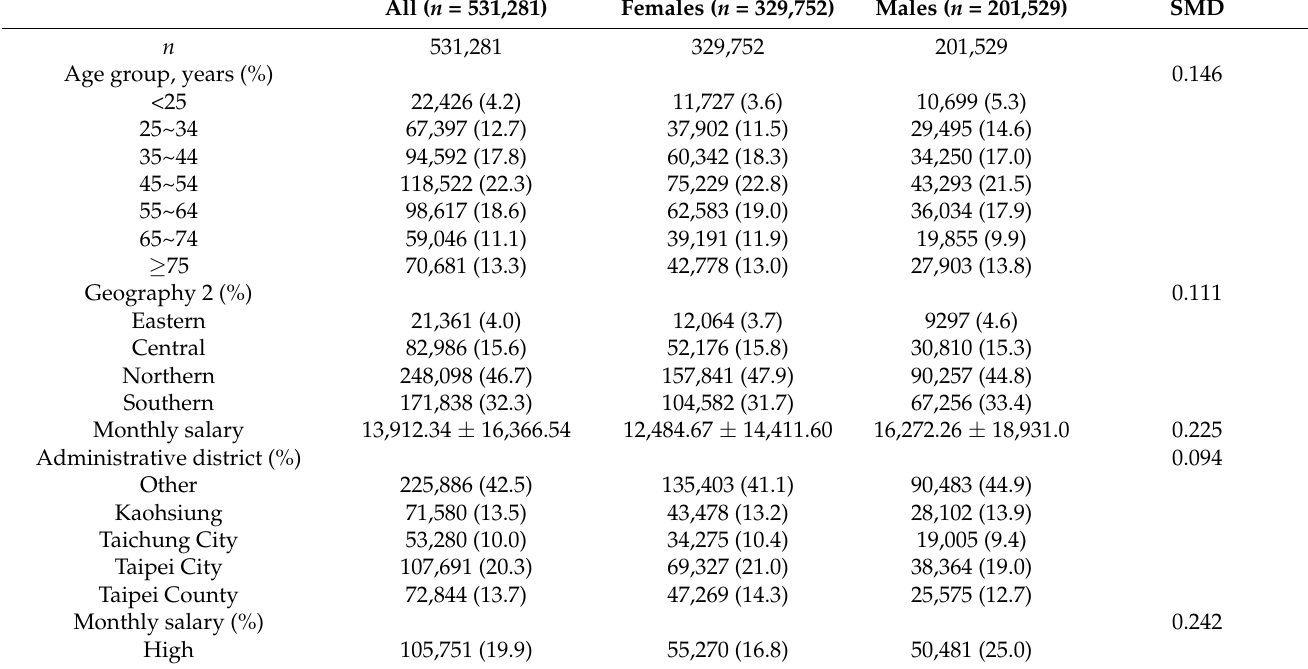
Table 1. Descriptive statistics of antidepressant prescriptions ( n =